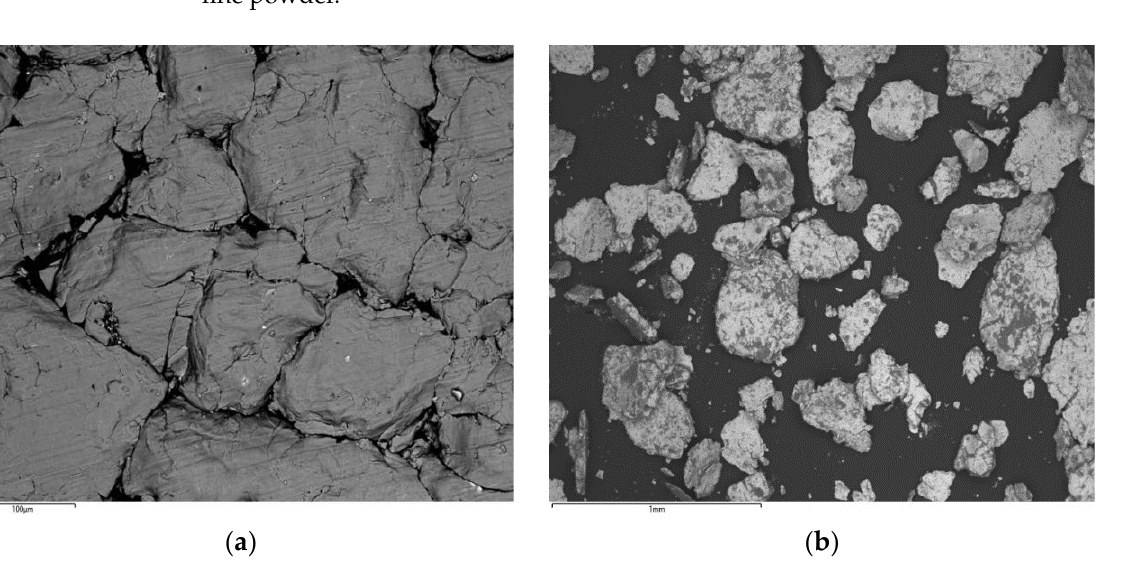
Table 2. Crystal parameters of Ti 16 V 60 Cr 24 at various initial states. Numbers in parentheses are the error son the last significant digit.